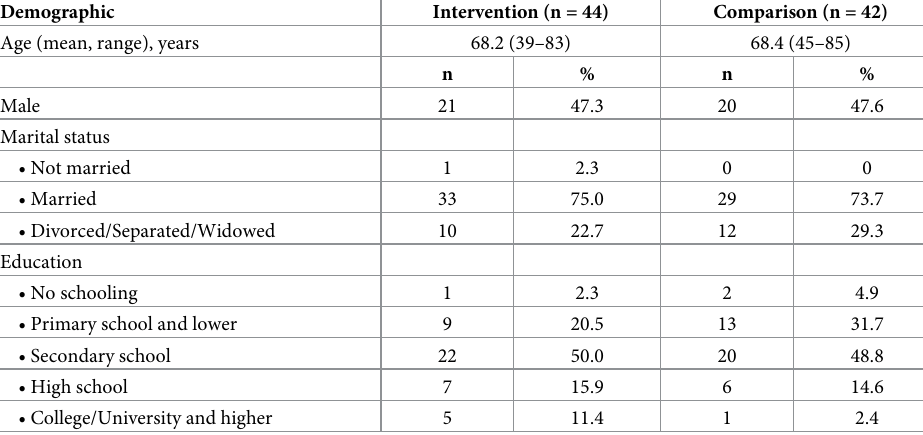
Table 1. Study population